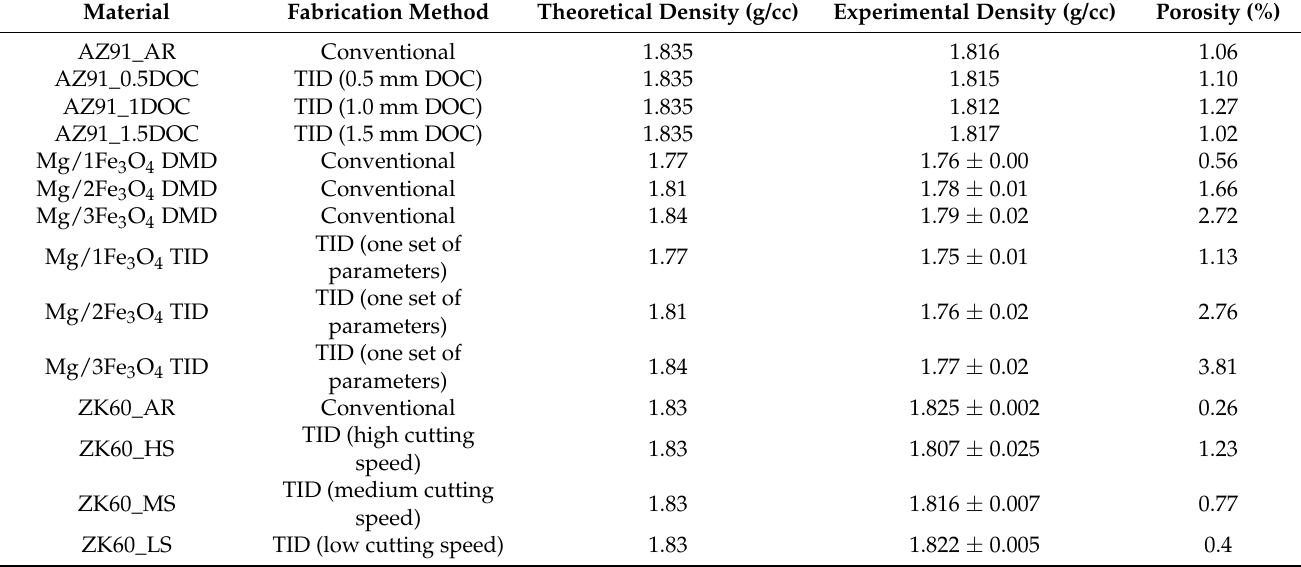
Table 1. Density and porosity values of Mg materials undergoing both conventional and TID method processing [18,24,25]. Material